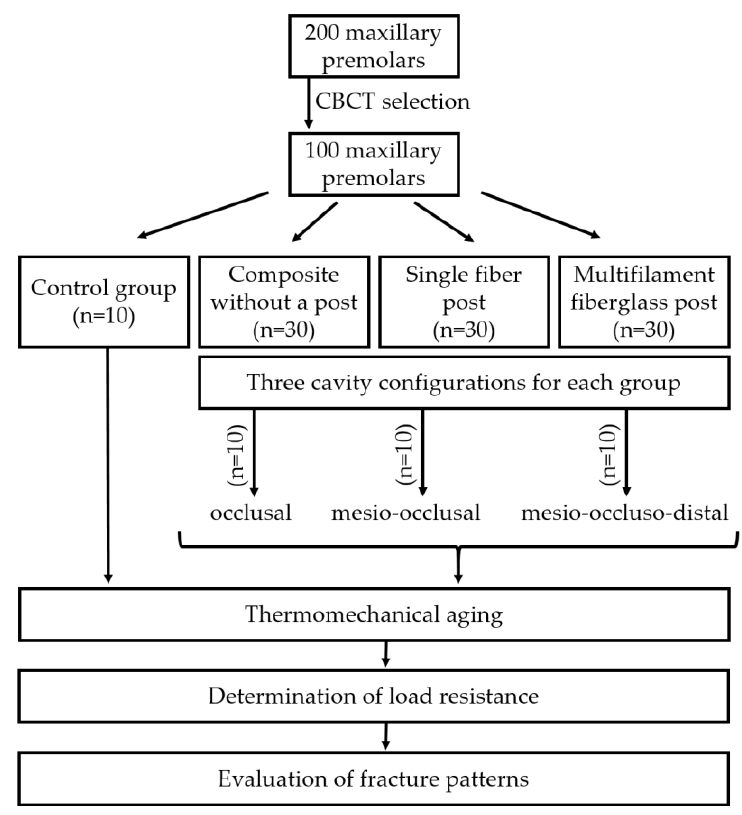
Figure 3. Flowchart of the methodological